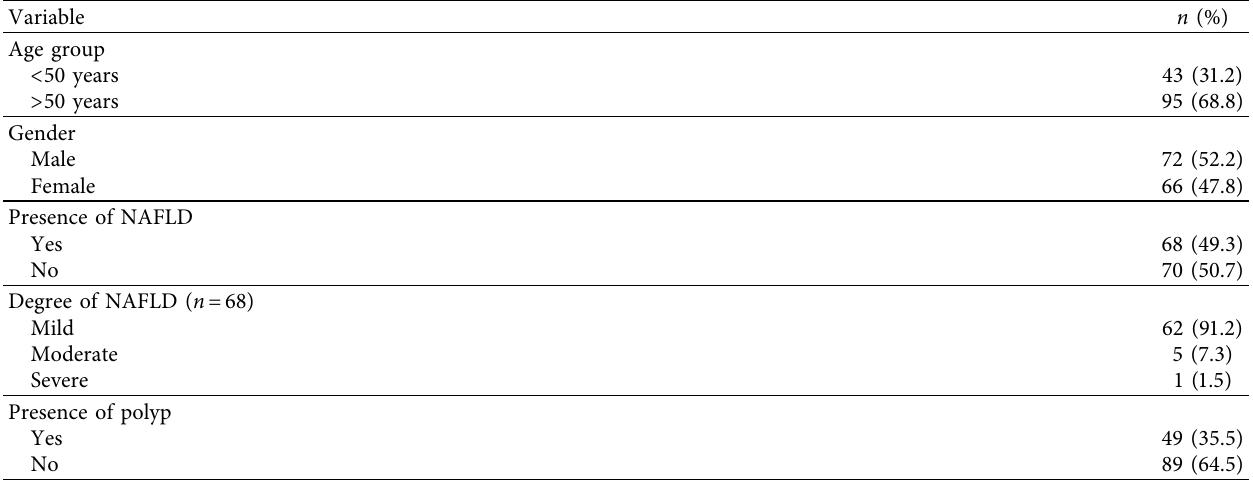
Table 1: Characteristics of the study subjects ( N � 138).